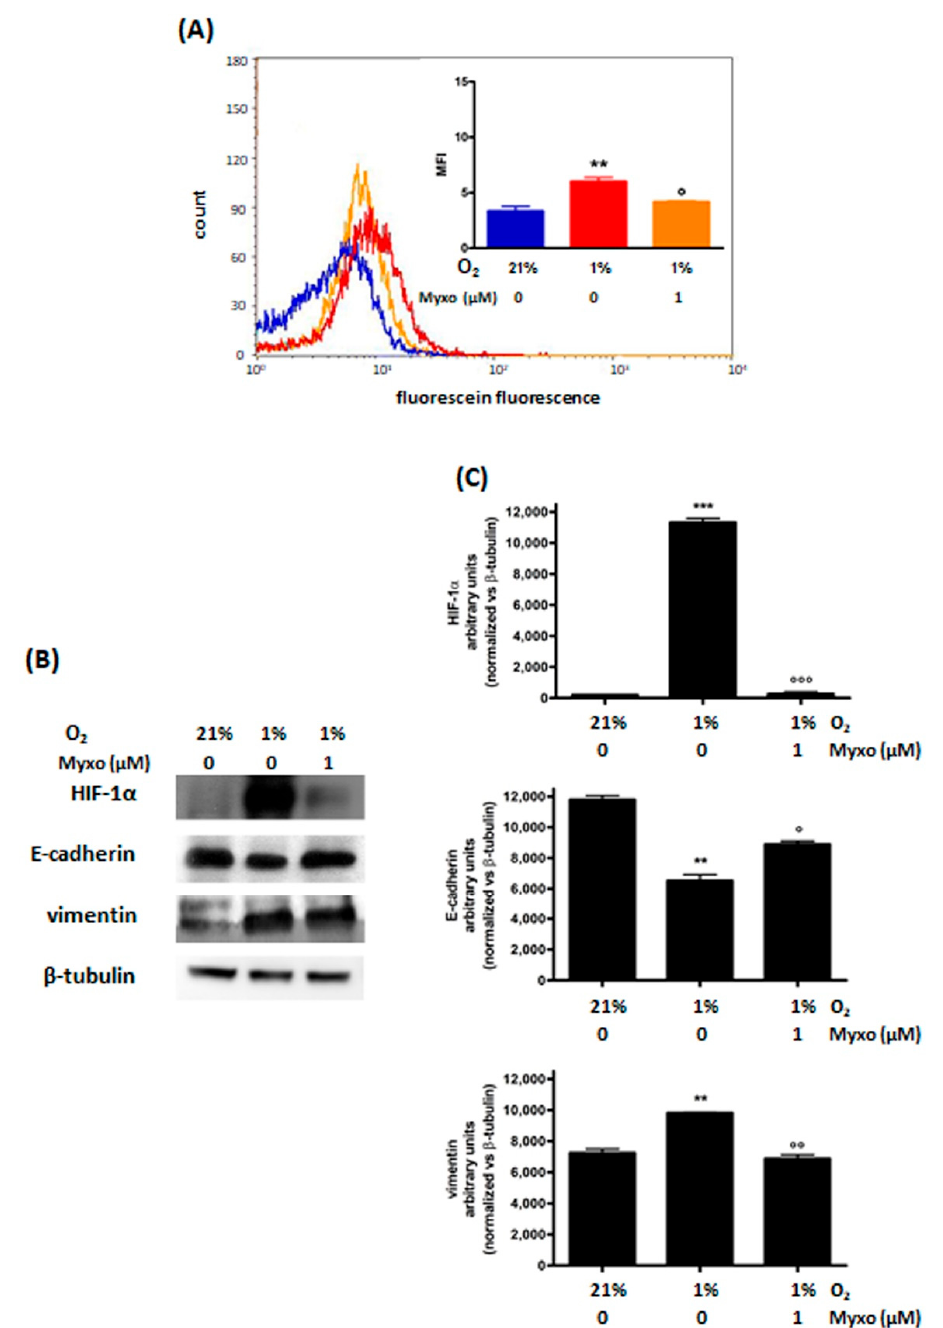
Figure 3. Effects of 48 h treatment with Myxo treatment (1 μ M) and incubation in normoxic (O 2 21%) or hypoxic (O 2 1%) conditions in MDA − MB468 cells: ROS ( A ) and HIF − 1 α , E − cadherin and vimentin ( B ) levels. The figure shows representative flow cytometric and Western blot analyses out of 3 inde- pendent experiments with similar results. For flow cytometric analysis of ROS levels ( A ; blue line: normoxic control; red line: hypoxic control; light blue line: hypoxic Myxo treated cells). The fluores- cence intensity was quantitated based on the Median Fluorescence Intensity (MFI) and results ob- tained in 3 independent experiments are reported in the graph. Densitometric analysis ( C ) was per- formed on all experiments (*** p < 0.001 and ** p < 0.01 vs. normoxic control; °°° p < 0.001, °° p < 0.01 and ° p < 0.05 vs. hypoxic control).